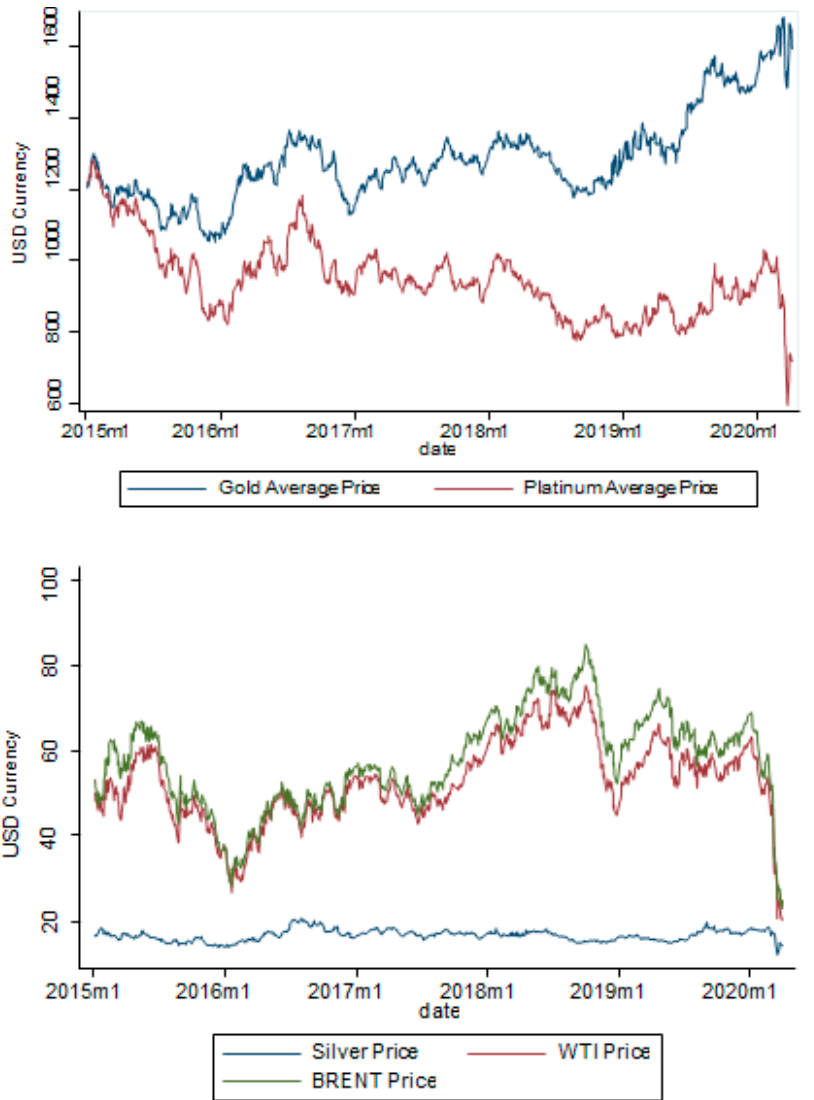
Figure 3. Commodity Price Behavior. Source: Data Stream (2020). A correlation analysis (see Table 1) measuring growth as percentage change using log-differences of these variables suggest that the contamination growth rate of Covid-19 is statistically significant and negatively correlated with the performance of the stock markets and the commodity prices, except for exchange rate and gold prices 1 . The highest negative correlation coefficients of the contamination growth rate of Covid-19 are with the price of the Brent oil barrel and the stock market performance.